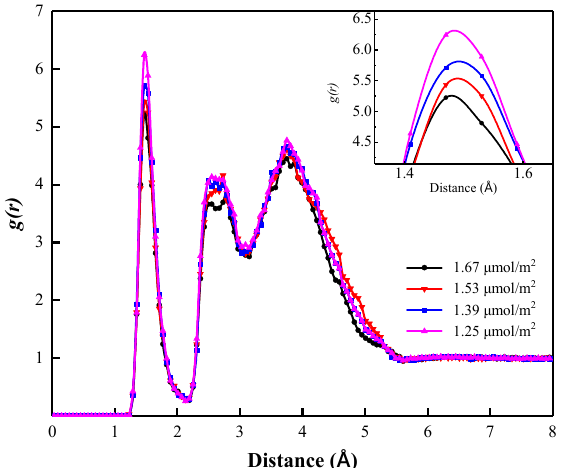
Figure 16. Radial distribution functions of SDBS head group and surrounding water molecules in foam systems with different SDBS concentrations.